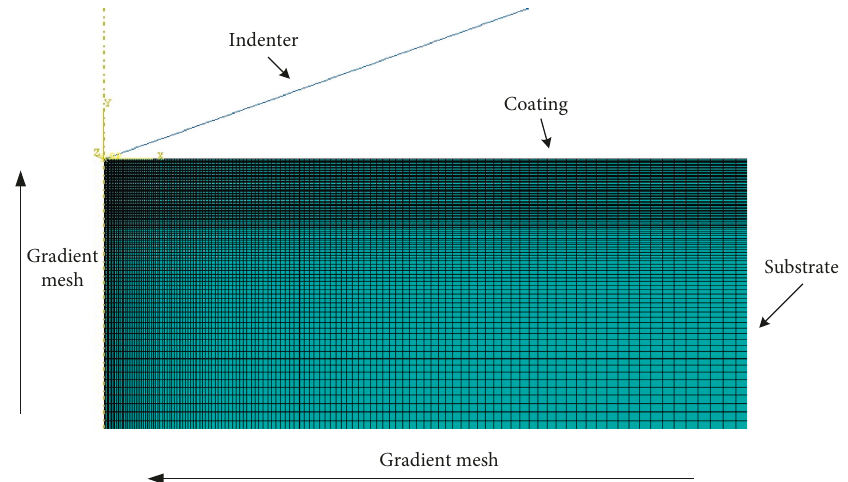
Figure 3: The model of the indenter and coating-substrate composite